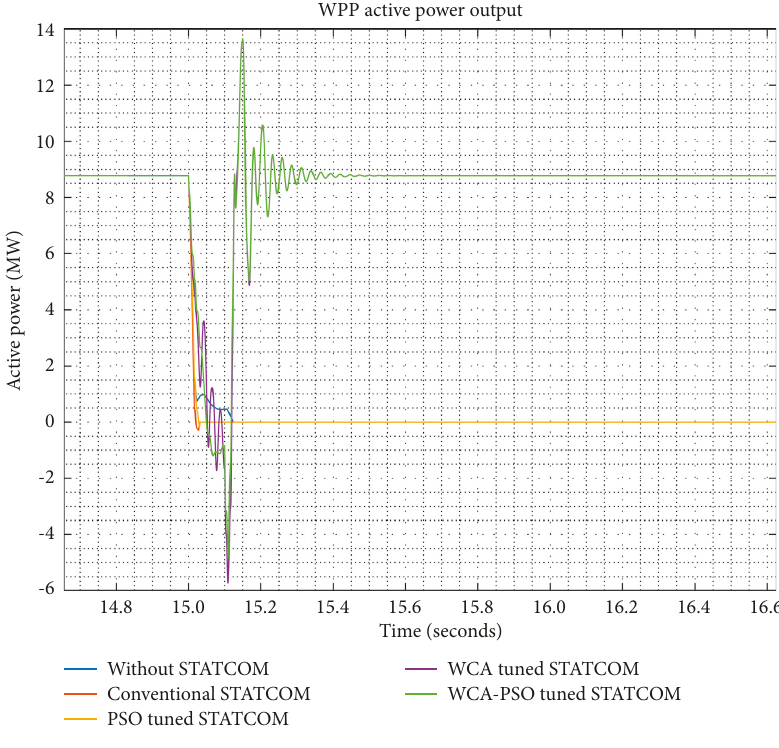
Figure 14: WPP active power output.